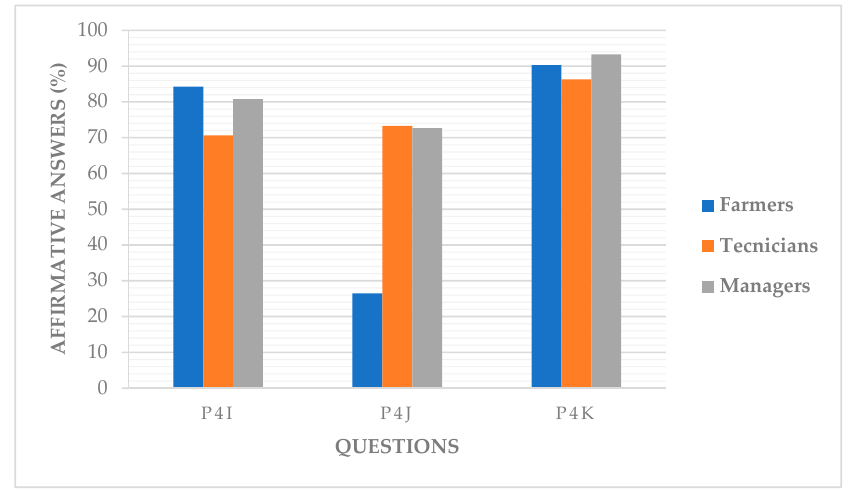
Figure 9. Common answers for questions in Block 3 (all groups).